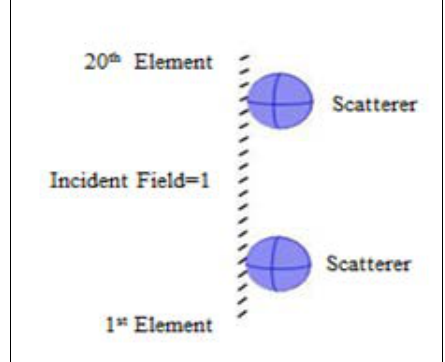
Figure 15: Geometric setup for case 3